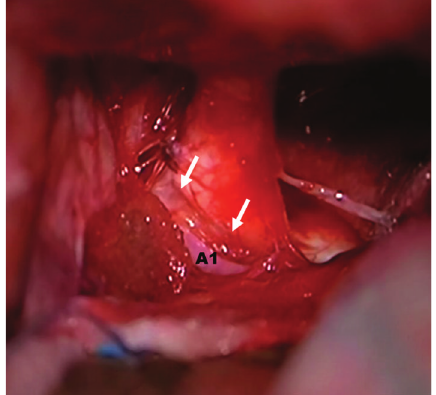
Figure 3: Intraoperative photograph showing a clear impression of the A1 segment after tumor removal and optic nerve vascular decompression.